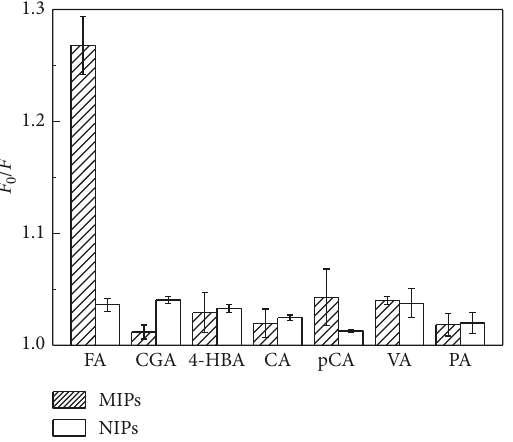
Figure 7: Quenching efficiencies of FA, CGA, 4-HBA, CA, pCA, VA, and PA (each concentration at 10 μ g/l) on CdTe-QDs@MIPs and